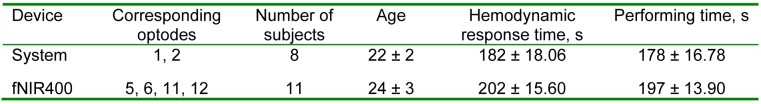
Data collected from developed system and commercial fNIRS devices, mean ± SD